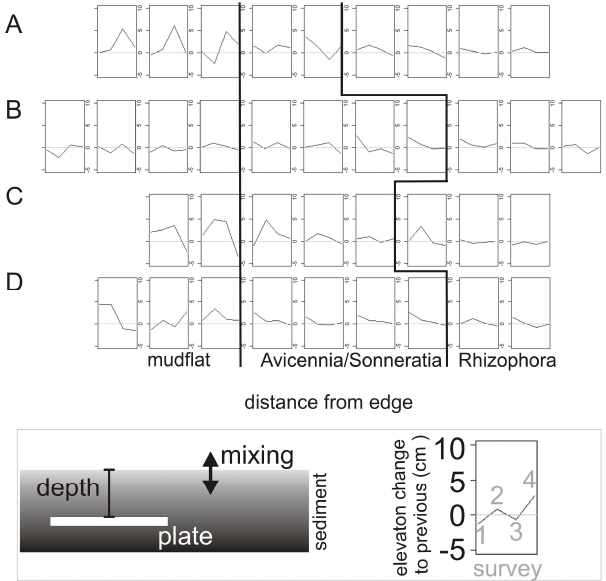
Fig. 3. Change in marker plate depth (positive values: accretion; negative values: erosion) in time for each plot from the mudflat (left) to the back of the forest (right). Five measurements of plate depth were taken in 8 months, leading to 4 points of change in time. The magnitude of change is highest on the mudflat and reduces towards the back of the